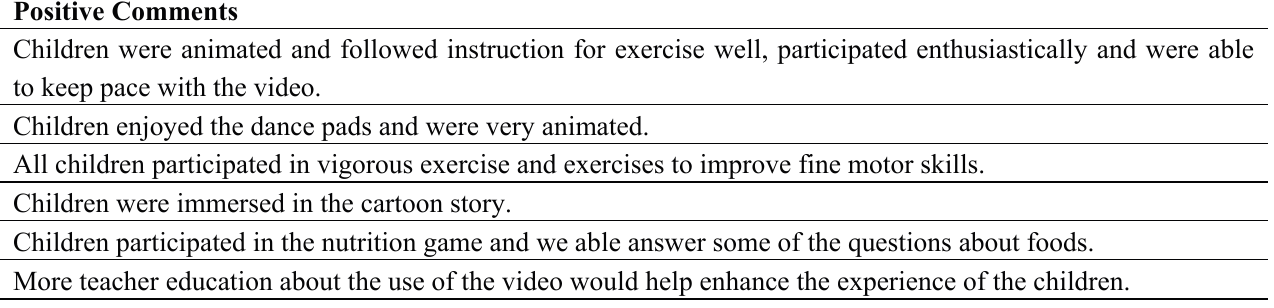
Table 3. Pilot video with the Head Start